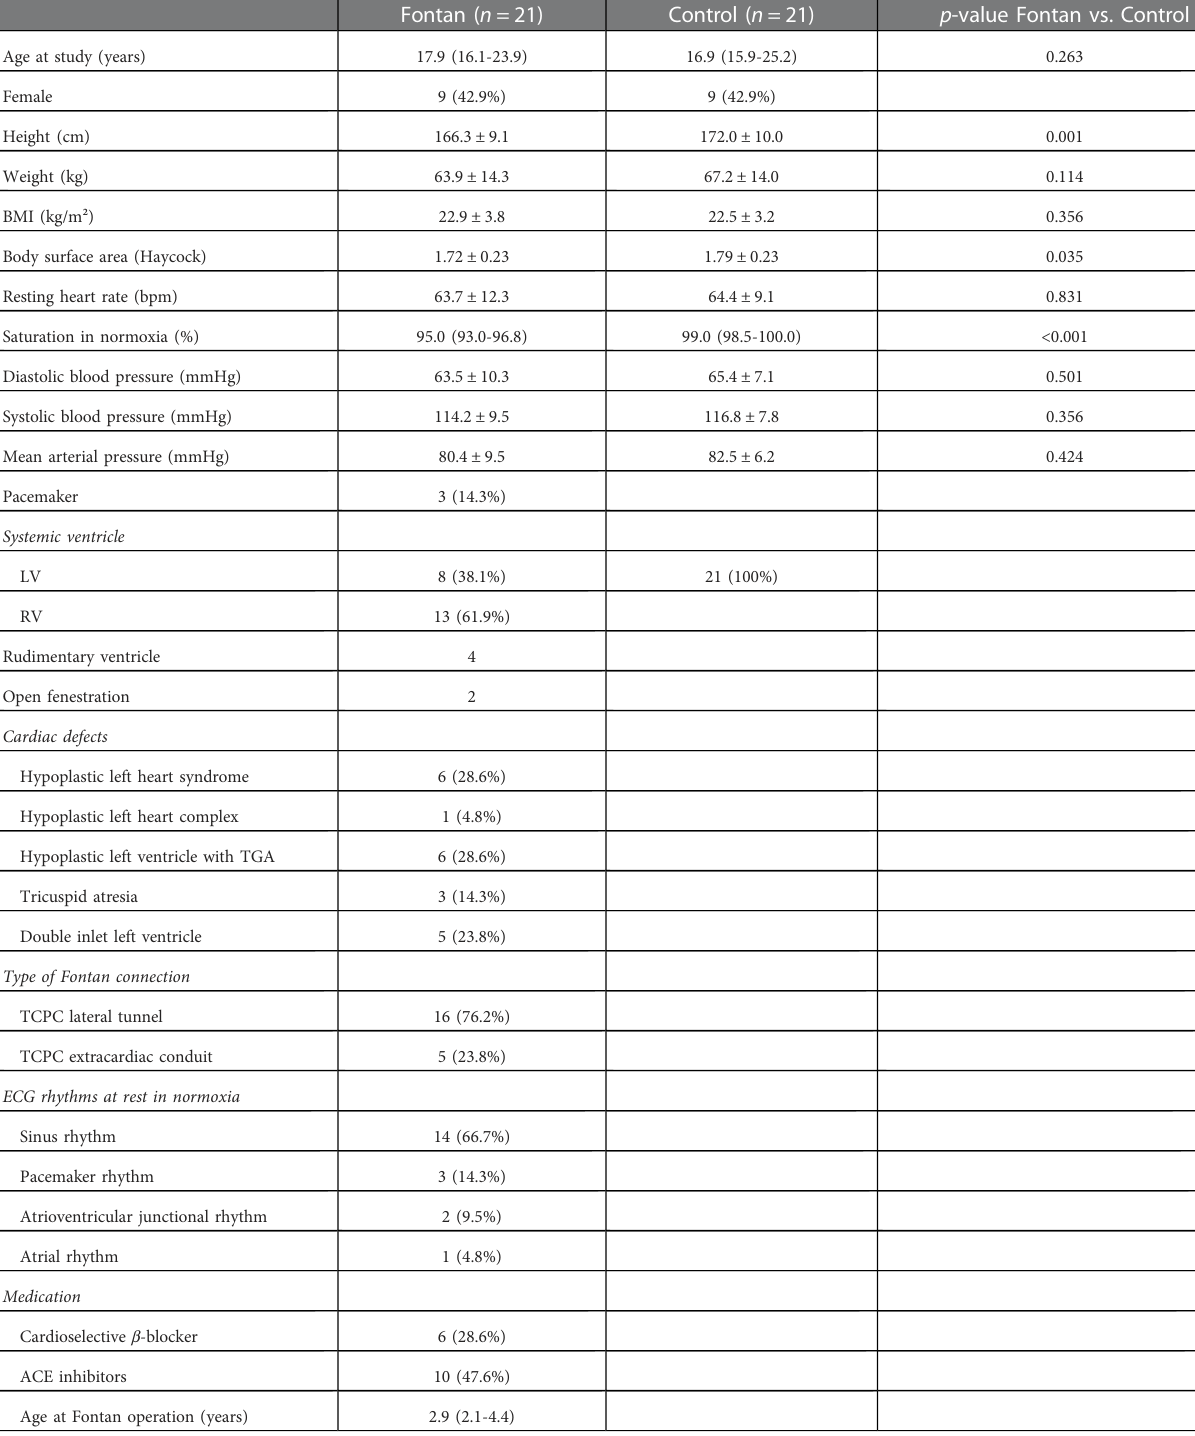
TABLE 1 Demographic